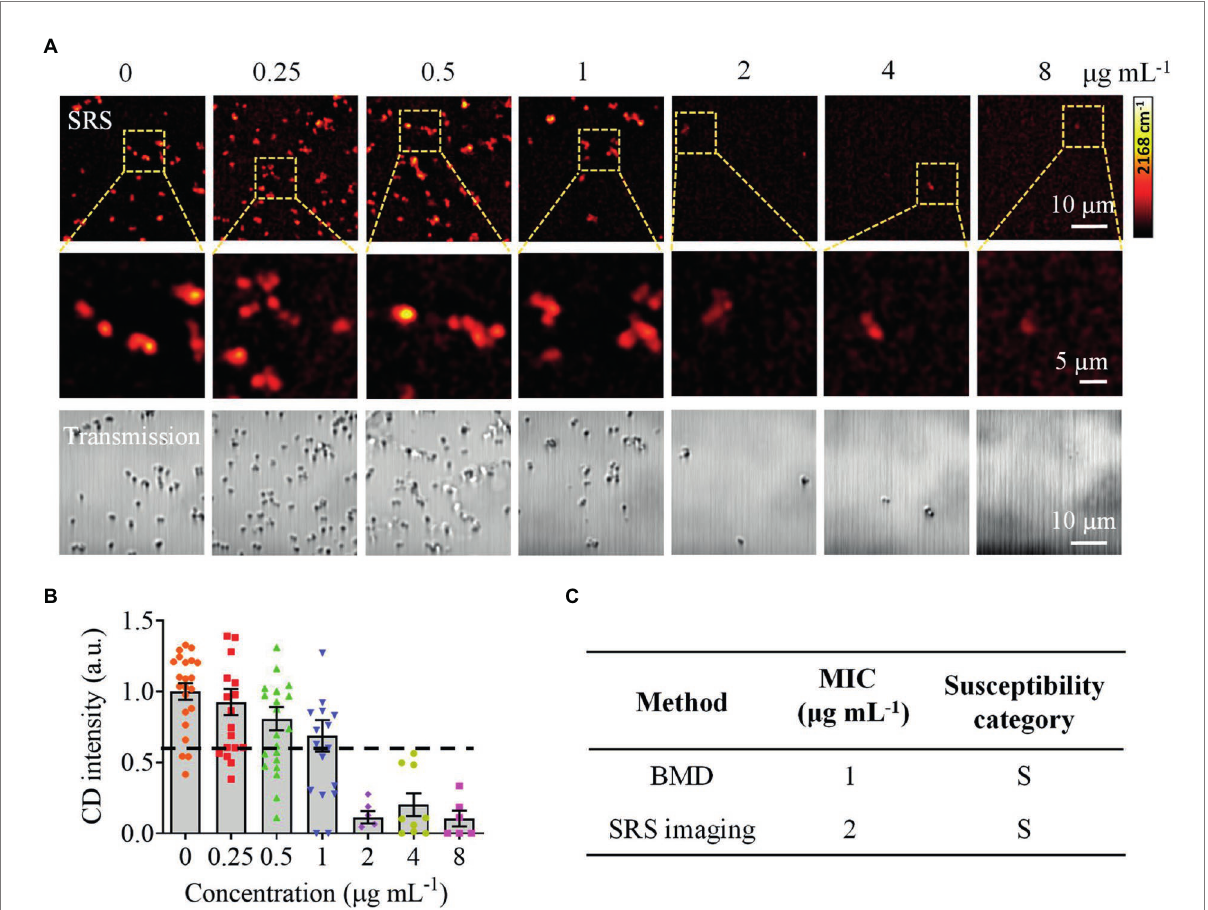
FIGURE 6 Rapid AST of S . aureus in urine by CRM. (A) SRS at C–D and corresponding transmission images of S . aureus (MIC BMD = 1 μ g mL − 1 ) after culture in a D 2 O-containing medium with serially diluted gentamicin. (B) Statistical analysis of the C–D intensity in S. aureus in (A) . (C) Comparison of the MIC and susceptibility category determined by the BMD and SRS imaging-based methods. S, sensitive. Error bars represent the standard error of the mean